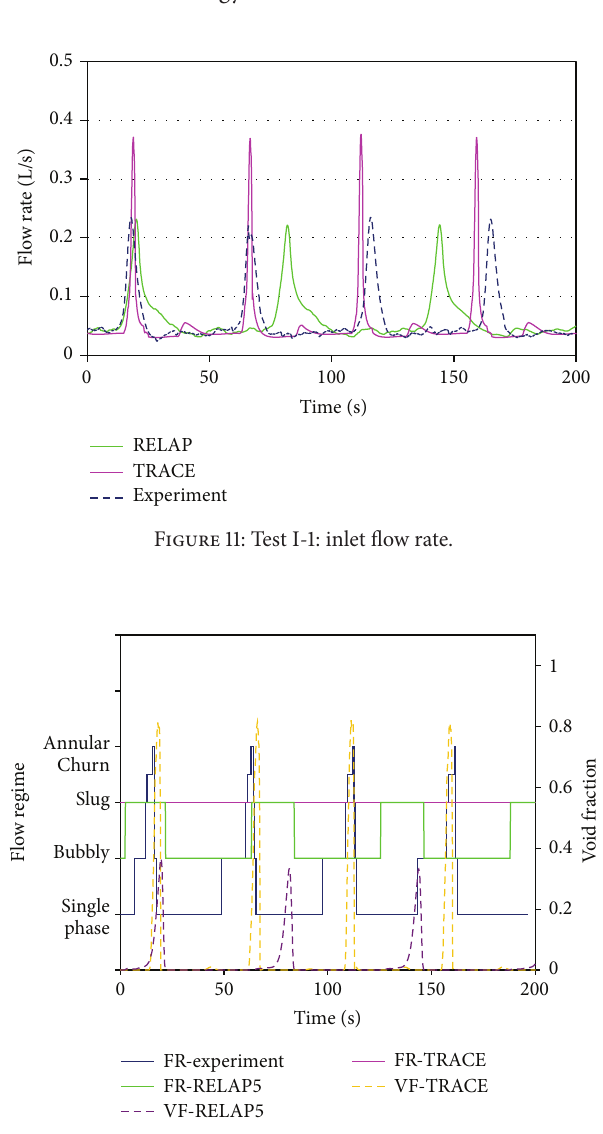
Figure 12: Test I-1: riser flow regime (FR) and void fraction (VF) in the section for visual